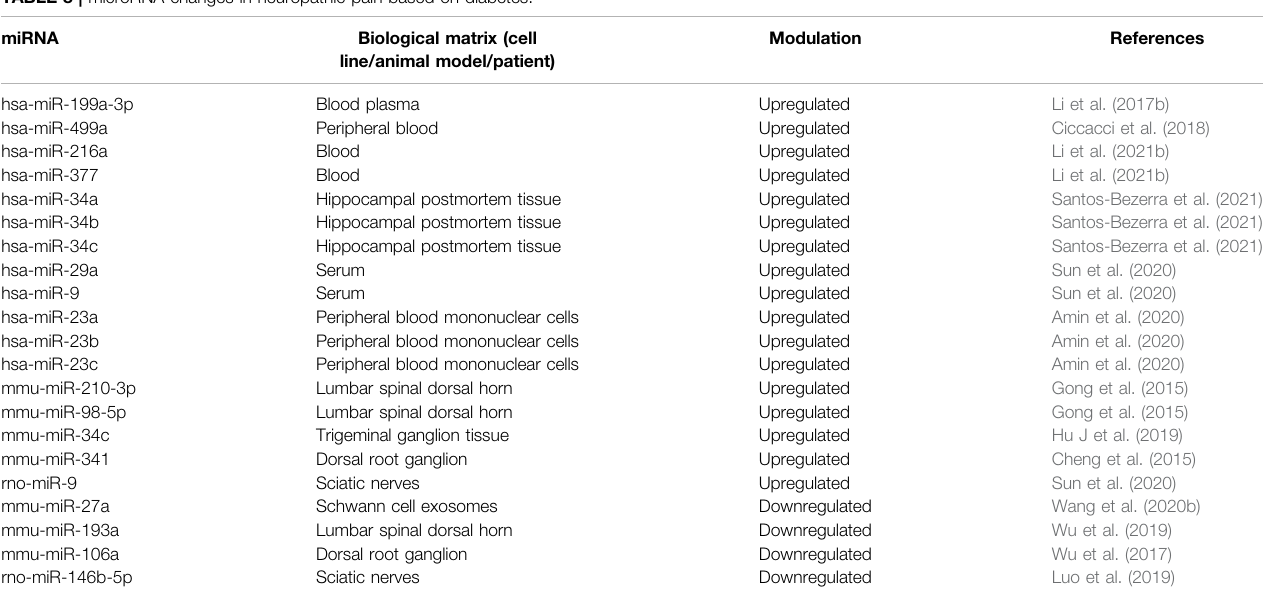
TABLE 8 | microRNA changes in neuropathic pain based on diabetes. miRNA Biological matrix (cell line/animal